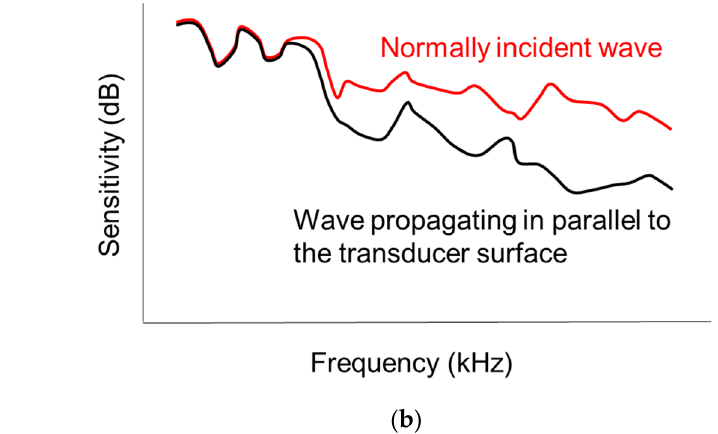
Figure 1. ( a ) Illustration of multiple cycles acting simultaneously on the sensor surface and ( b ) sensitivity vs. frequency curve of a transducer for waves impinging at normal angle and parallel (inspired by [9]).